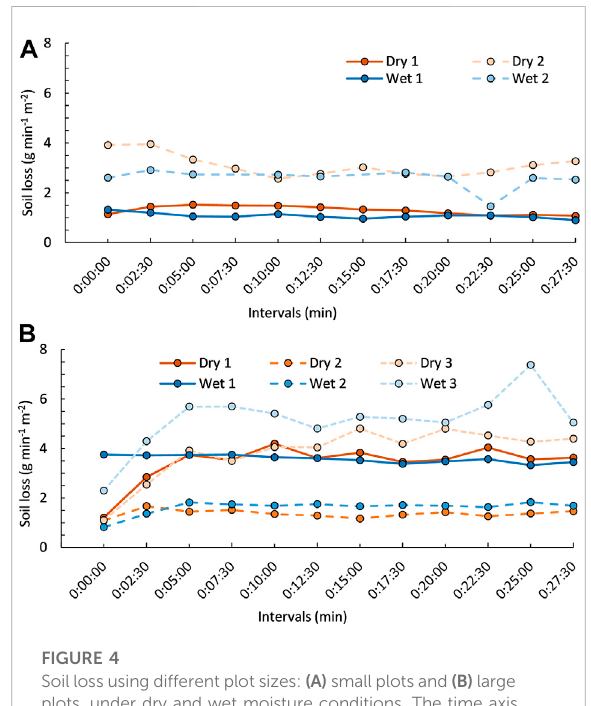
FIGURE 3 Surfacerunoffusingdifferentplotsizes: (A) smallplotsand (B) large plots, under dry and wet moisture conditions. The time axis provides the relative time from the start of the surface runoff.